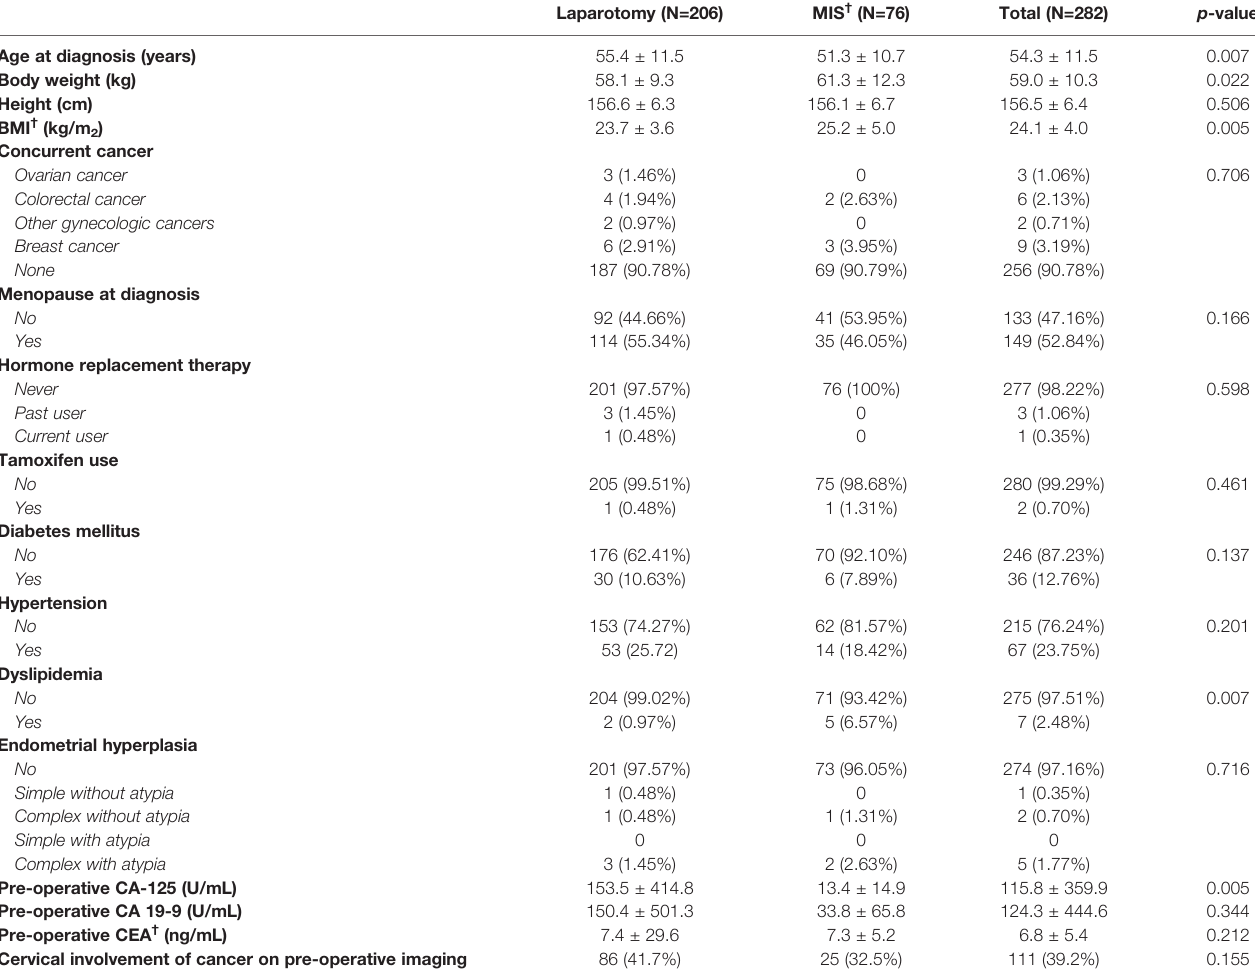
TABLE 1 | Baseline characteristics of the